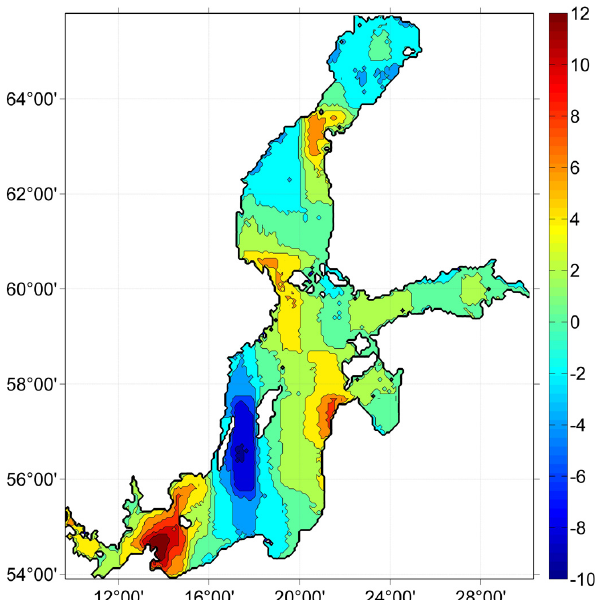
Fig. 4. Long-term changes in the annual average significant wave height (cm, based on the linear trend, isolines plotted after each 2cm) for 1970–2007.